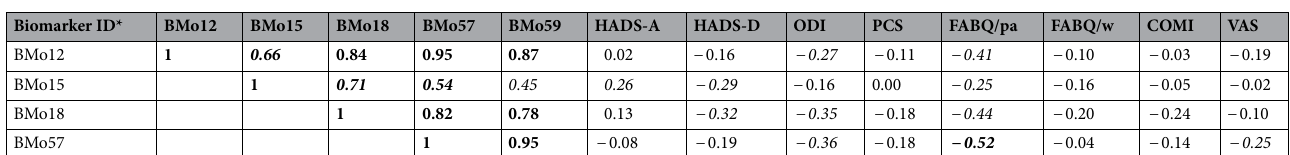
Table 5. Correlations between biomarkers values and PROMs. *Biomarker identifiers (ID) used in the systematic review of Moissenet et al. 6 . See Table 1 for the characteristics. Data reported as r value